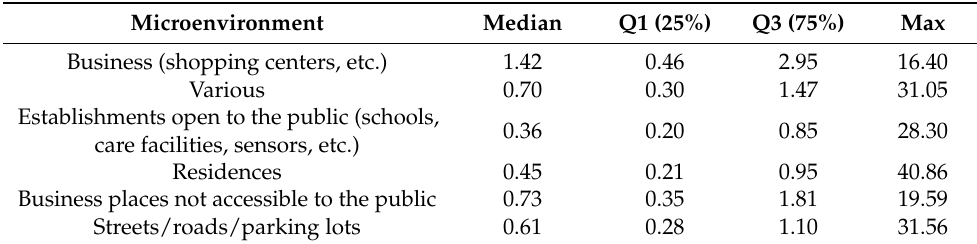
Table 4. Descriptive statistics parameters (median, 25th, and 75th percentiles and maximum) for the E (V/m) values measured in various microenvironments in France.